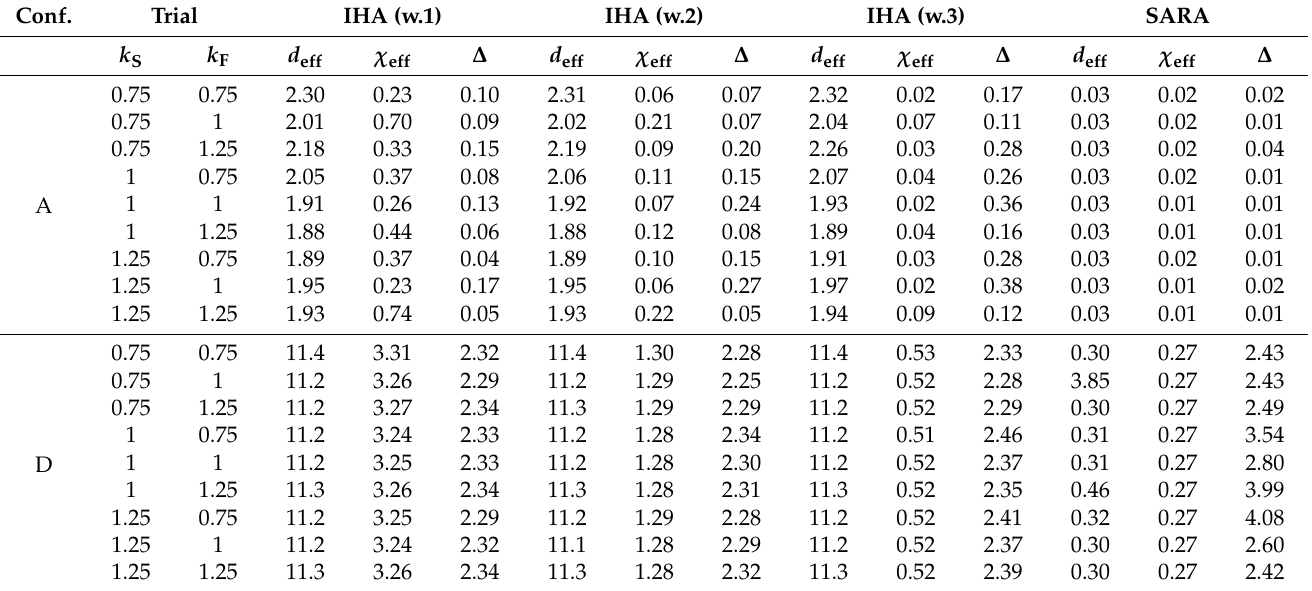
Table A2. Dispersion parameters ( d eff , in mm, and χ eff , in deg) and rms distance ( ∆ , in mm) between exact and estimated AoRs for different levels of marker scattering in each cluster. k S refers to the shank, k F to the foot (details in Section 2.1.1). Results are given for A and D motion configurations.